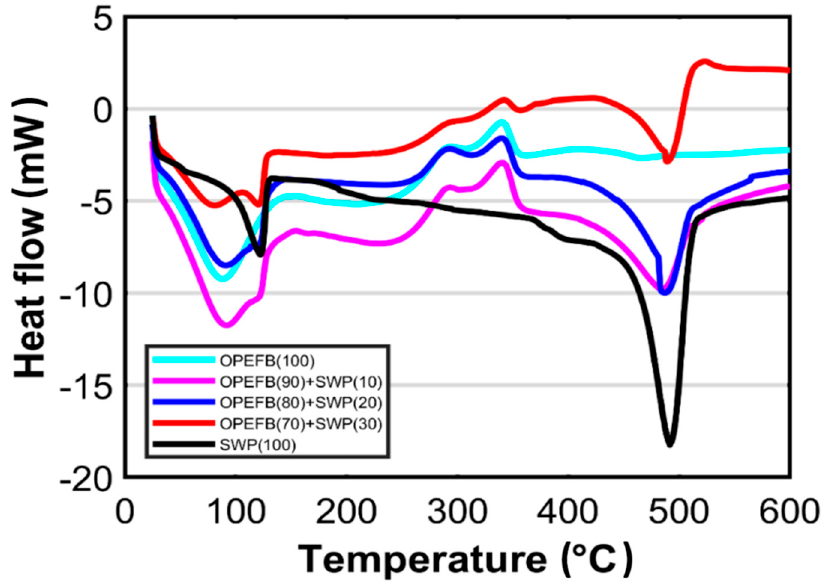
Figure 3. DSC evolutions of sample species evaluated (15 °C min -1 ).